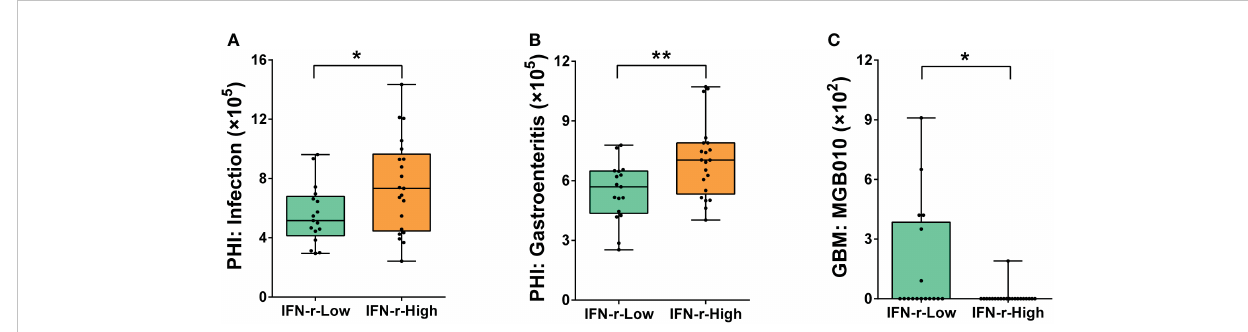
FIGURE 6 Differences of the abundances of genes related to pathogen-host interactions and gut – brain modules in the fecal microbiome between the IFN- g - Low and IFN- g -High groups. The values of the points represent the relative abundances of genes related to (A) infection (Pathogen gene: purT , Host species: Homo sapiens ), (B) gastroenteritis (Pathogen gene: fl hF , Host species: Homo sapiens ) and (C) gut – brain module MGB010 associated with histamine degradation. The horizontal line and the box indicate the median and the interquartile range (IQR), and the whisker spans the minimum to maximum. * p <0.05, ** p <0.01.